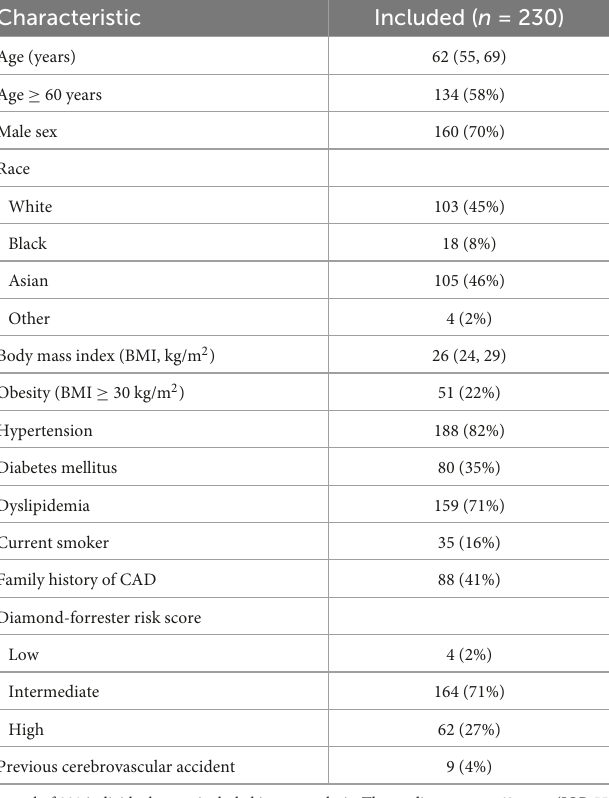
TABLE 2 Clinical characteristics of the study